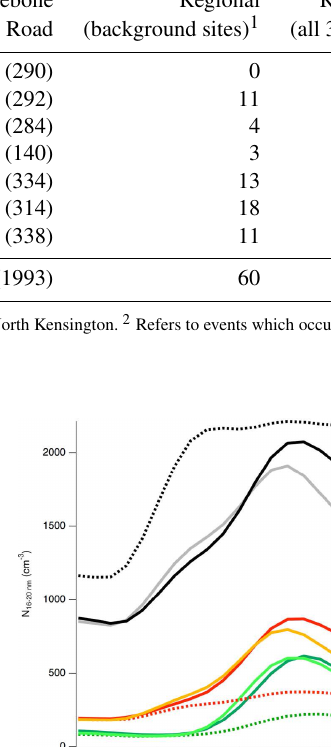
Table 1. Number of NPF events per site (in parenthesis the number of days with available data). Harwell N. Marylebone Regional Regional Kensington Road (background sites) 1 (all 3 sites) 2